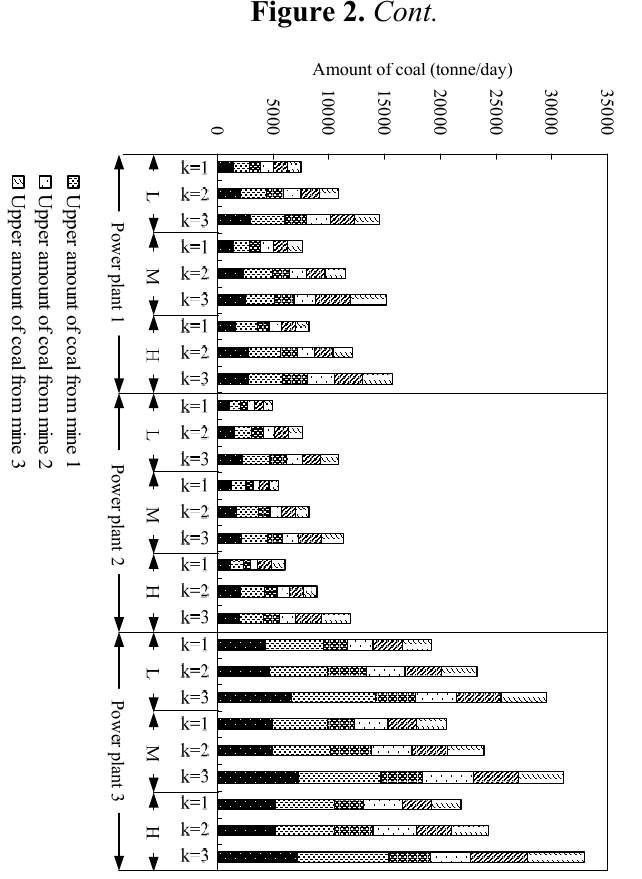
Figure 3. Optimized excess coal flows to the power plants under scenarios 1 and